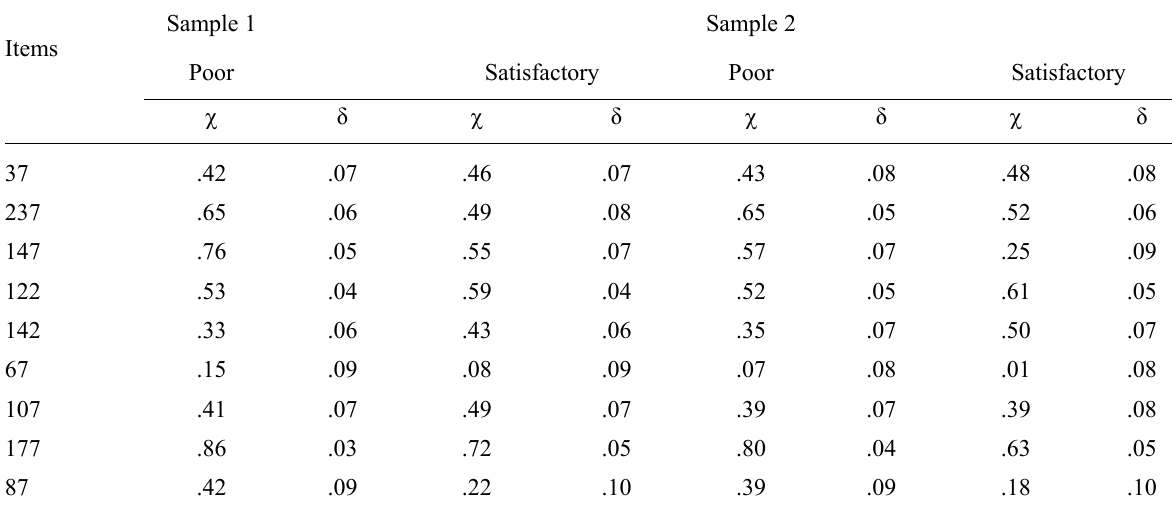
Completely Standardized MLE Parameter Estimates for Poor and Satisfactory Fitting Single-Factor Models: Extraversion Sample 1 Sample Items